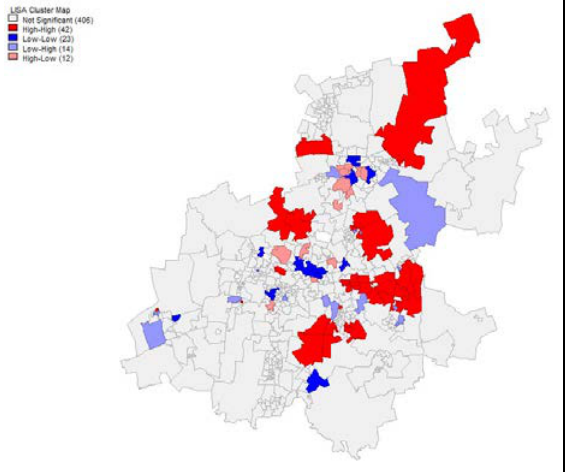
Figure 11. Cluster map of intensity of poverty (%) in 2011